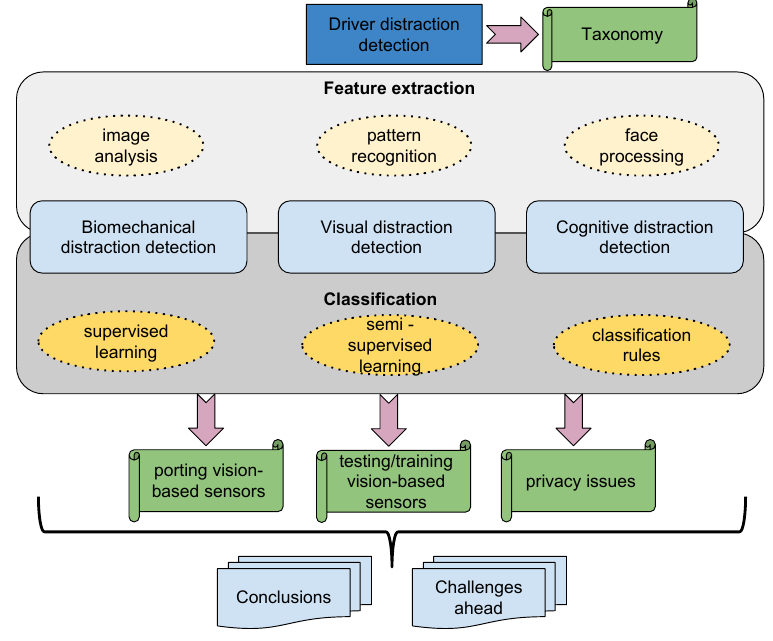
Figure 1. Scope of the present